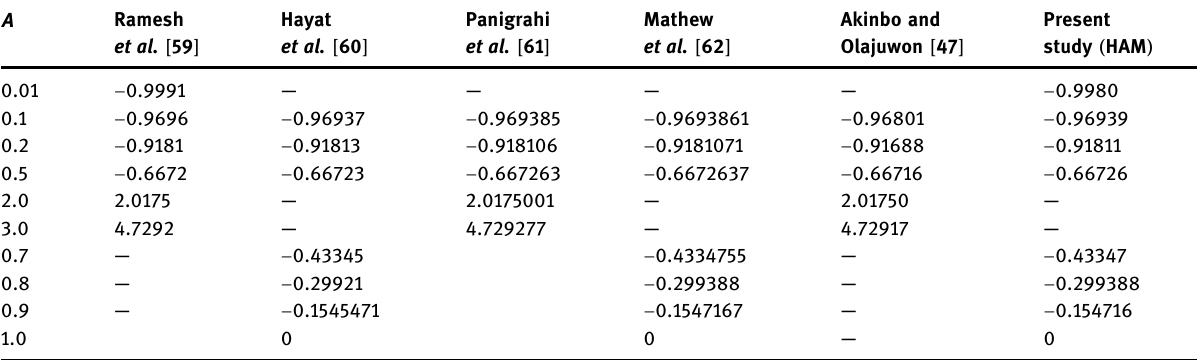
Table 2: Comparison of f ″ 0 ( ) with the works of Ramesh et al. [ 59 ] , Hayat et al. [ 60 ] , Panigrahi et al. [ 61 ] , Mathew et al. [ 62 ] , and Akinbo and Olajuwon [ 47 ] in the limiting case when β δ